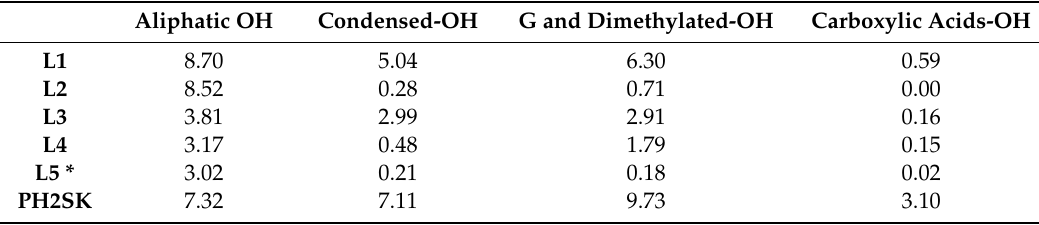
Table 3. Number of OH in the lignin fractions as determined by 31 P NMR analysis.